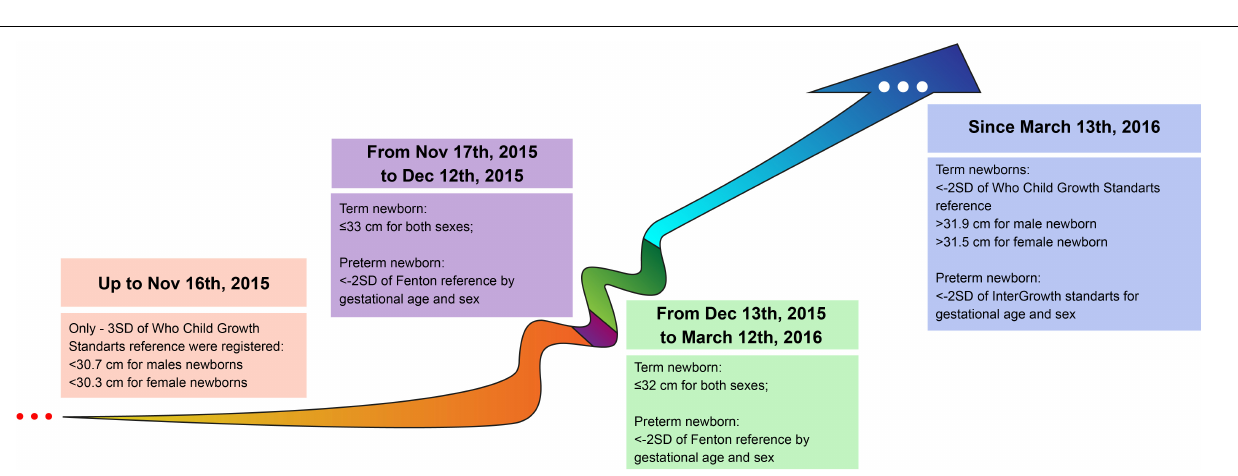
FIGURE 2 | Evolution of diagnostic criterion based on head circumference (HC) between 2015 and 2016 in Brazil (the epicenter of cases). Before the first wave of cases, HC cutoff was more restrictive ( < 30.7 cm for males and < 30.3 cm for females), from Nov 17th, 2015 when the epidemic was clearly established the cutoff was altered to ≤ 33 cm for both sexes in the attempt to track new cases. This lack of distinction between sexes was kept up to March 12th, 2016, which might have overestimated particularly female cases.